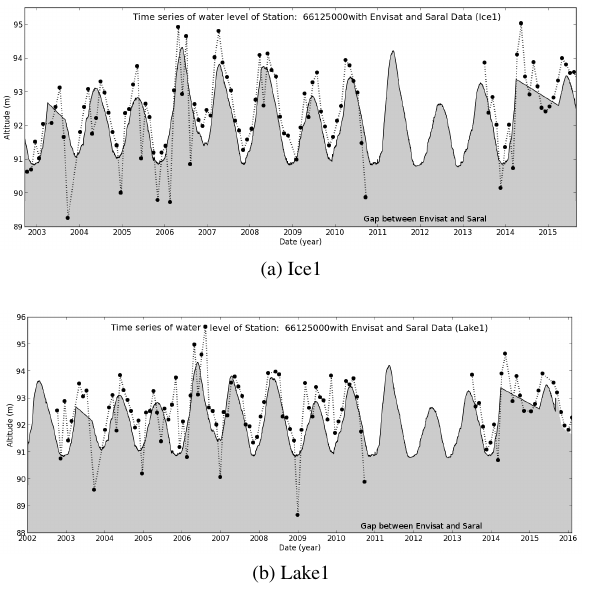
Figure 4: Time series combining Envisat and Saral data for the Ice1 (top) and Lake1 (bottom) retrackers.